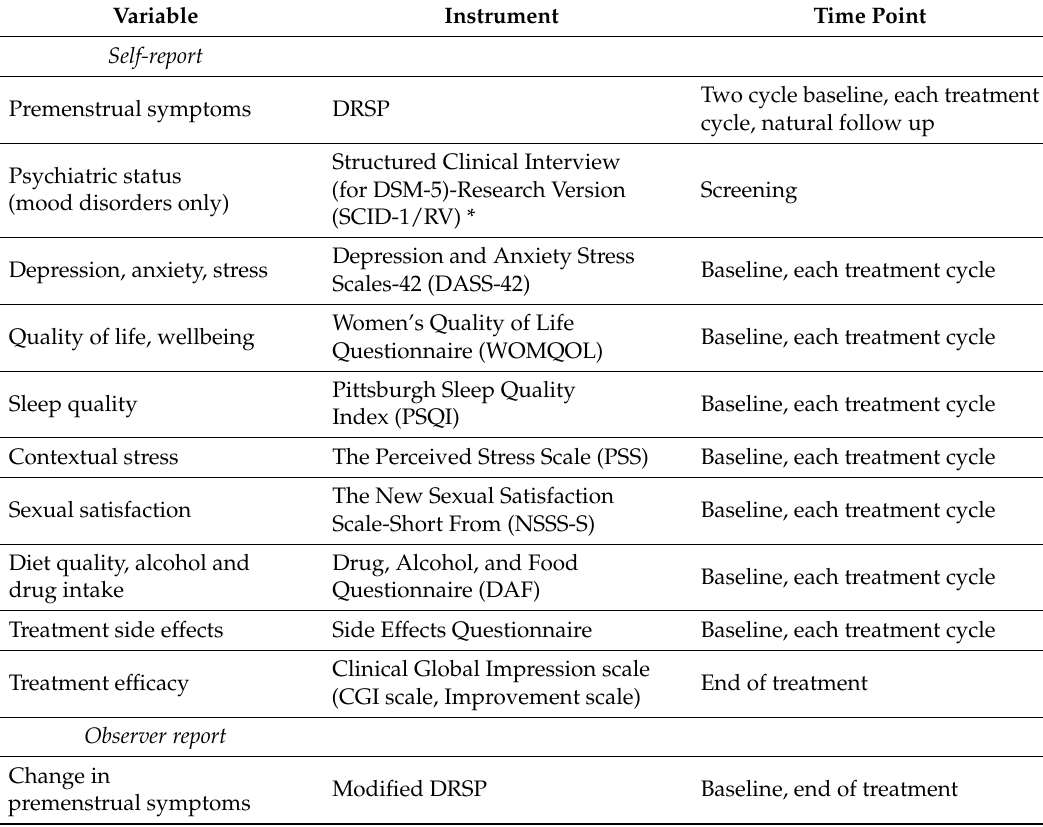
Table 2. Schedule of